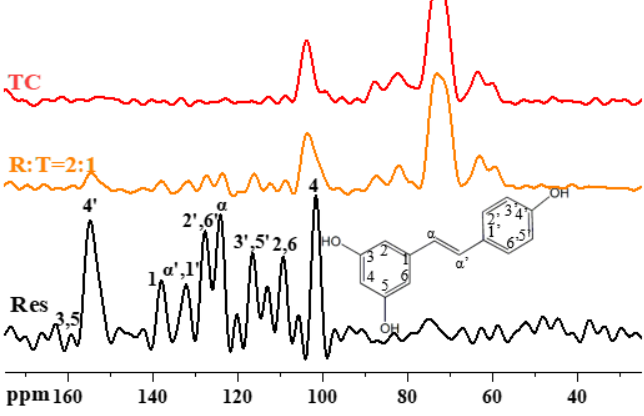
Figure 6. Solid-state CPMAS 13C-NMR spectra of Res, TC, and R:T = 2:1.